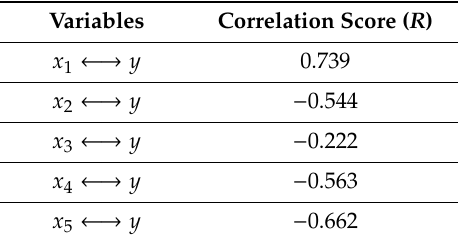
Table 3. Correlation score for feature selection.